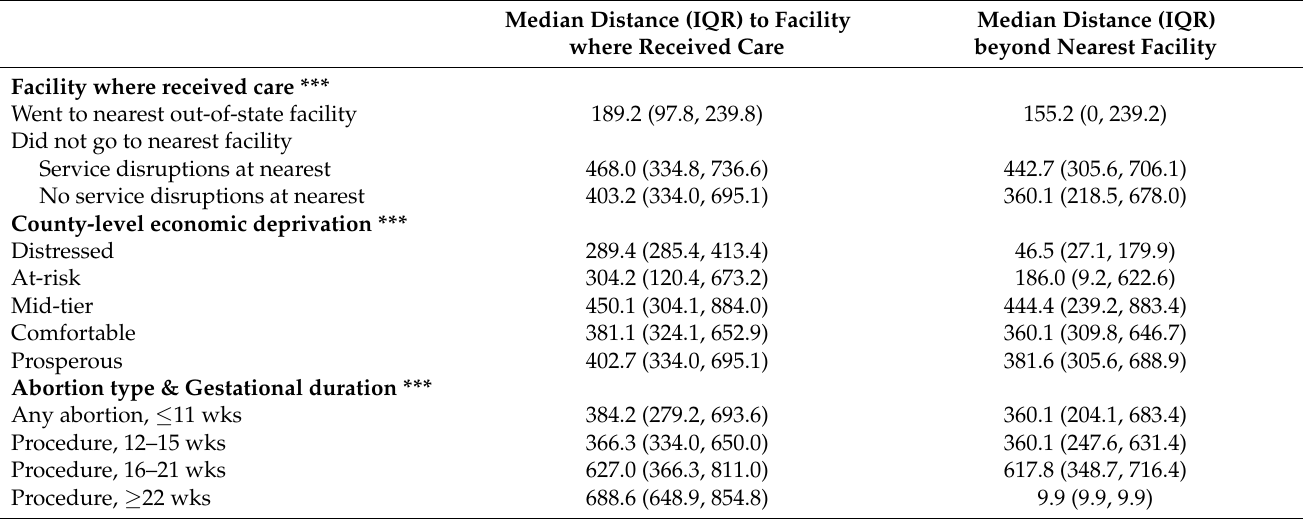
Table 4. One-way distance traveled to out-of-state abortion facilities during Texas’ executive